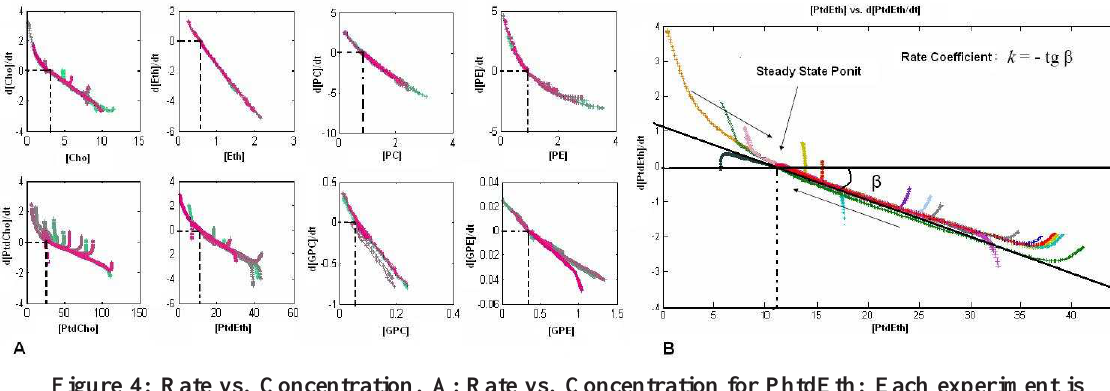
Figure 4: Rate vs. Concentration. A: Rate vs. Concentration for PhtdEth: Each experiment is shown by a different colour in this diagram. The steady state is obtained when the concentration of PtdEth is around 11 µmol.g − 1 . B: Rate vs. Concentration: Each diagram corresponds to the change in concentration of one reactant vs. its reaction rate. We define the slope ( k ) as ’rate coefficient’ which is used as a parameter in analysis concerning the speed of reaching the steady state. Values are given in µmol.g − 1 for Concentrations and in µmol.g − 1 .s − 1 for Rates